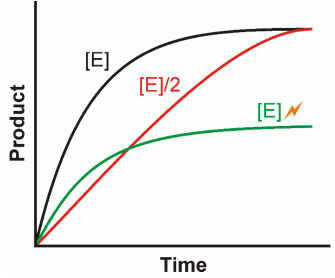
Figure 1. Exemplary product-over-time progression curves for an exemplary enzymatic reaction. The product-over-time curves are shown for different conditions including different enzyme con- centrations ([E] and [E]/2 shown in black and red) and inhibited or degraded enzyme (green). [E], enzyme